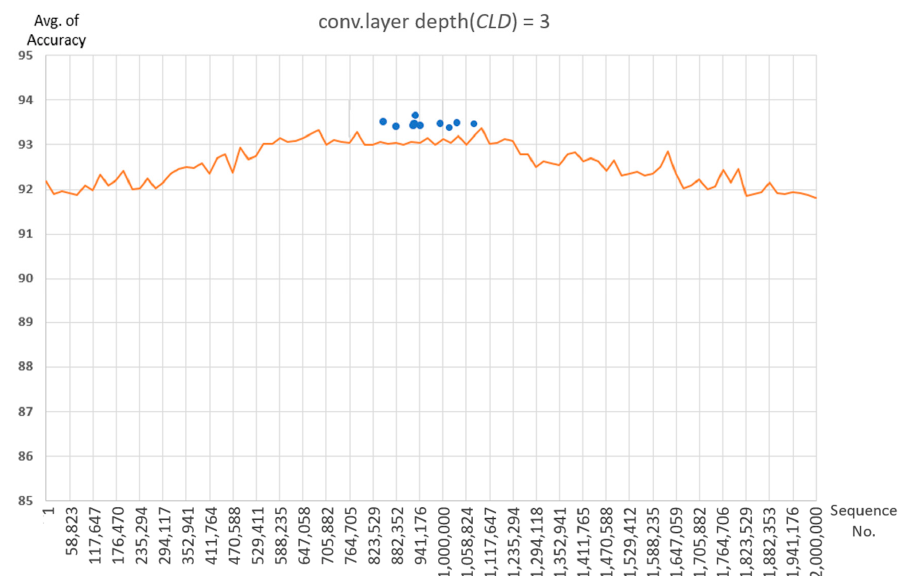
Figure 9. Out of the results of 10 times repeated learning on the CLD = 3, the points where the highest recognition rate per repetition time are located are marked.